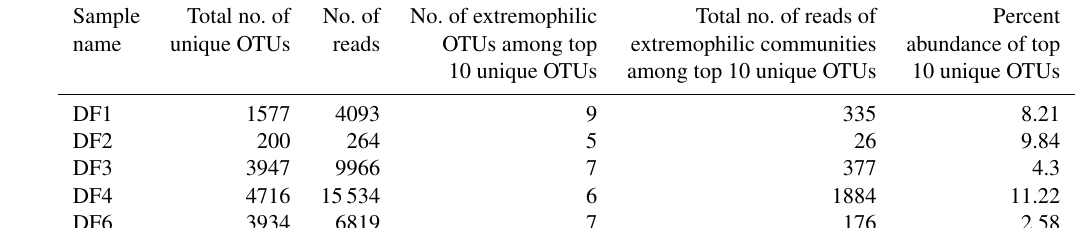
Table 2. Analysis of the unique operational taxonomic units (OTUs).